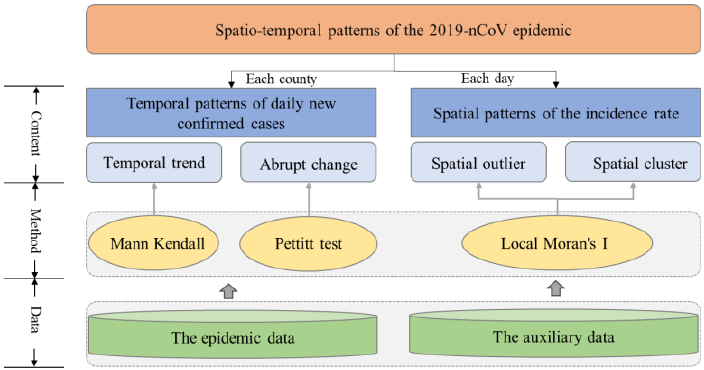
Figure 2. The main analytical framework used in this study .